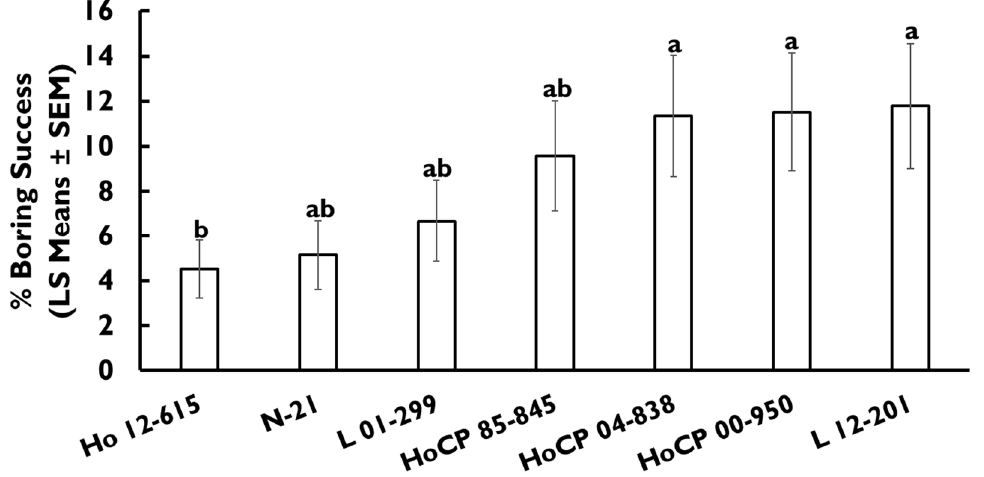
Figure 2. Eoreuma loftini neonate establishment among commercial sugarcane cultivars in greenhouse trial. Bars with the same letter do not differ significantly (Tukey–Kramer HSD, α = 0.05). Standard error of means analyzed with a binomial distribution are reported.